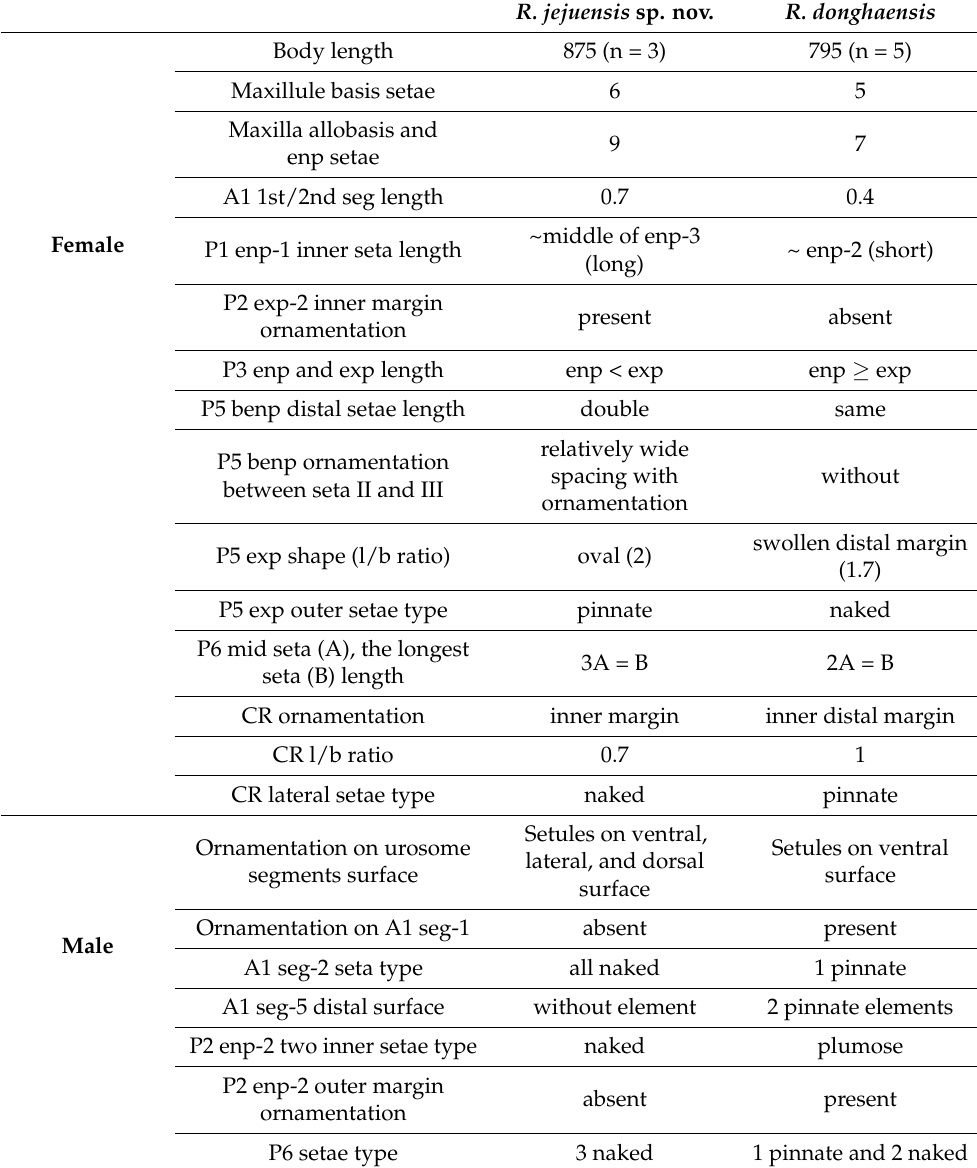
Table 3. Morphological comparison of new species and R. donghaensis